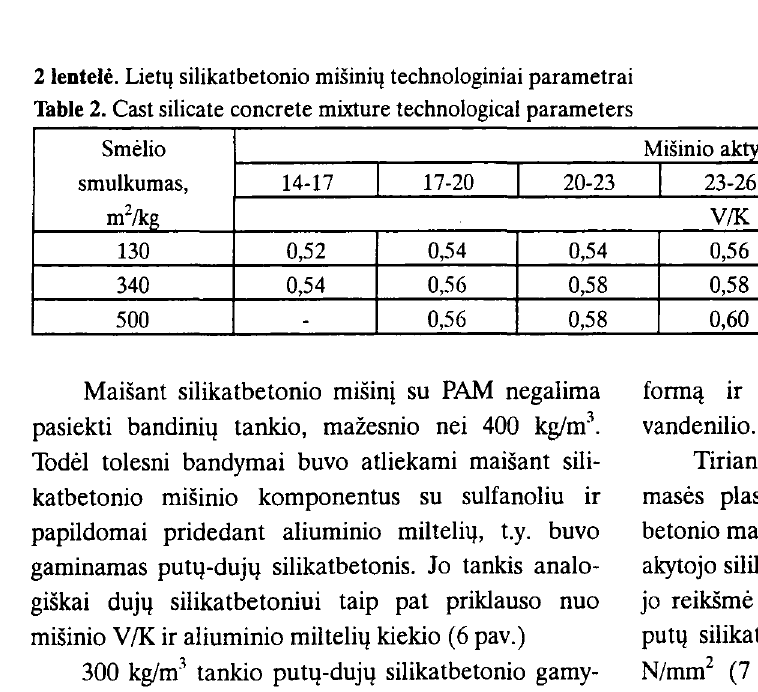
Table 2. Cast silicate concrete mixture technological parameters